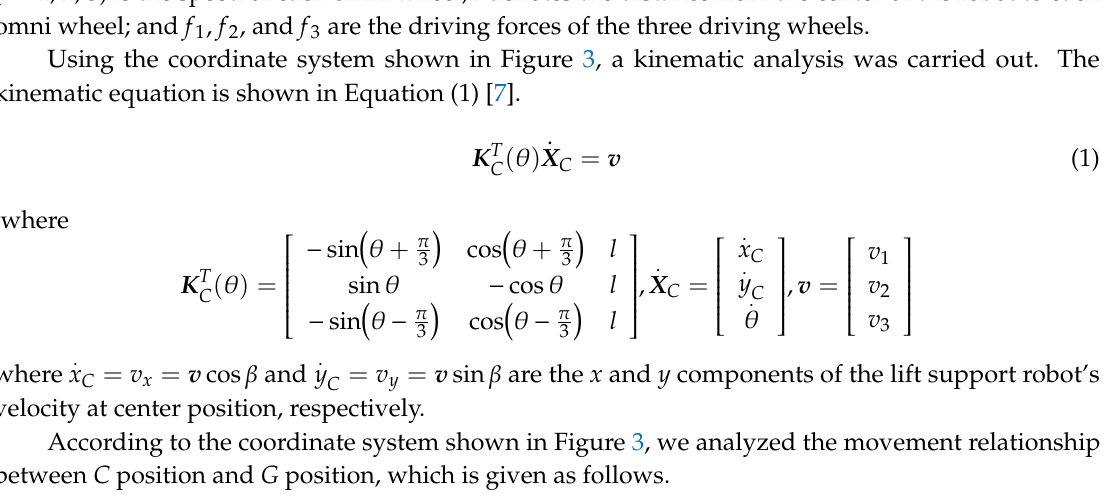
Figure 3. Structural model of the indoor carrier robot.